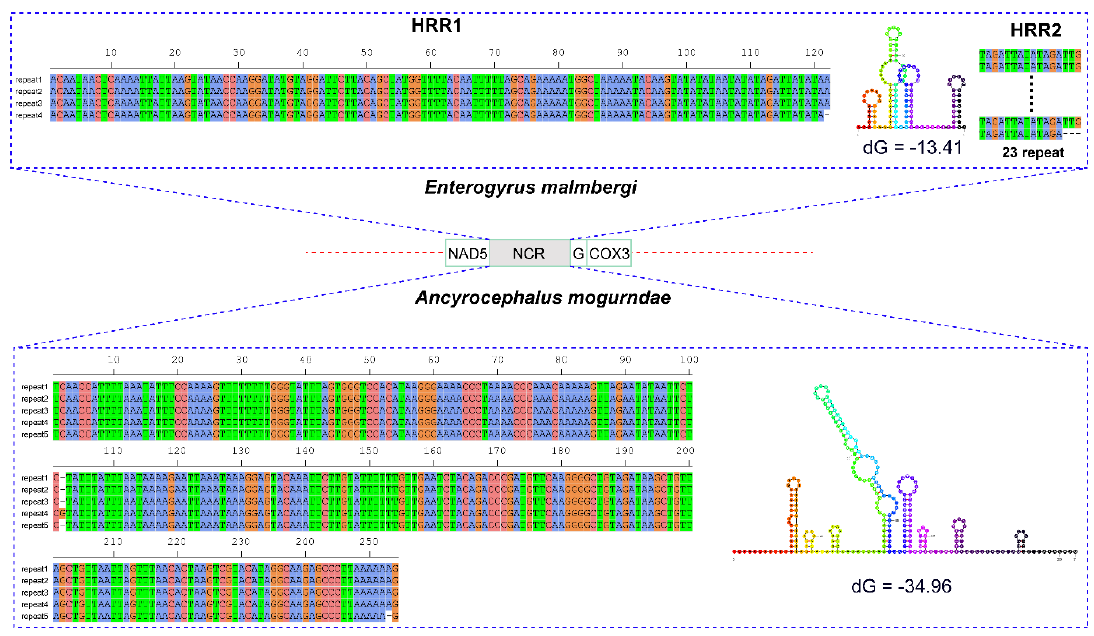
Figure 2. Stem-loop structures of the consensus repeat pattern in repetitive regions (RRs) of the non-coding region (NCR) of A. mogurndae and E. malmbergi . Thermodynamic energy values (dG) are shown next to the secondary structures. Only the NCR containing RRs was shown.